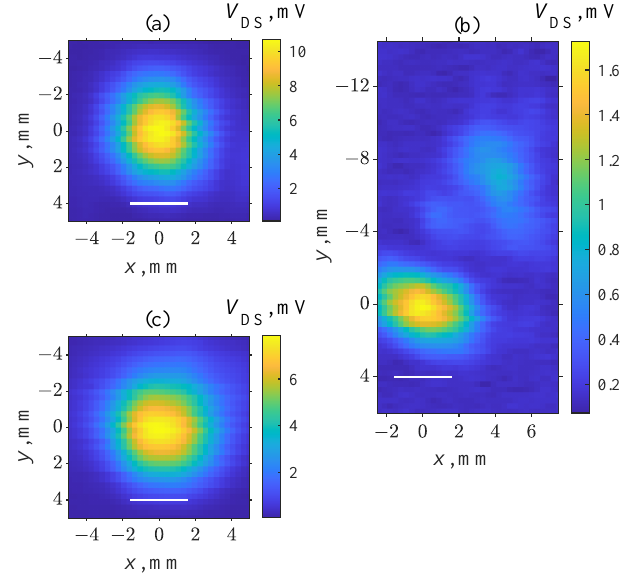
Figure 4. Beam profile images obtained at 94 GHz using: CE3520K3 transistor in PCB configuration “(b)” for horizontal ( a ) and vertical ( b ) electric field polarization; CE3521M4 transistor in the “(b)” PCB configuration for vertical electric field polarization ( c ). One-wavelength-long white lines are shown for an easier comparison.